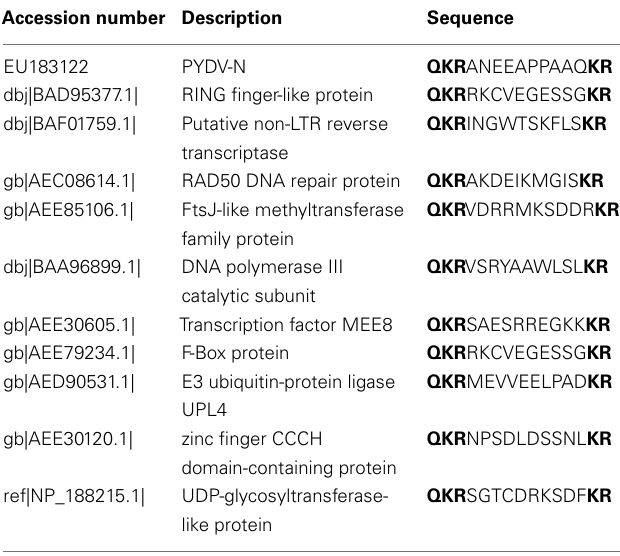
Table 1 | Nuclear localization signals in nucleocapsid proteins of nucleorhabdoviruses.